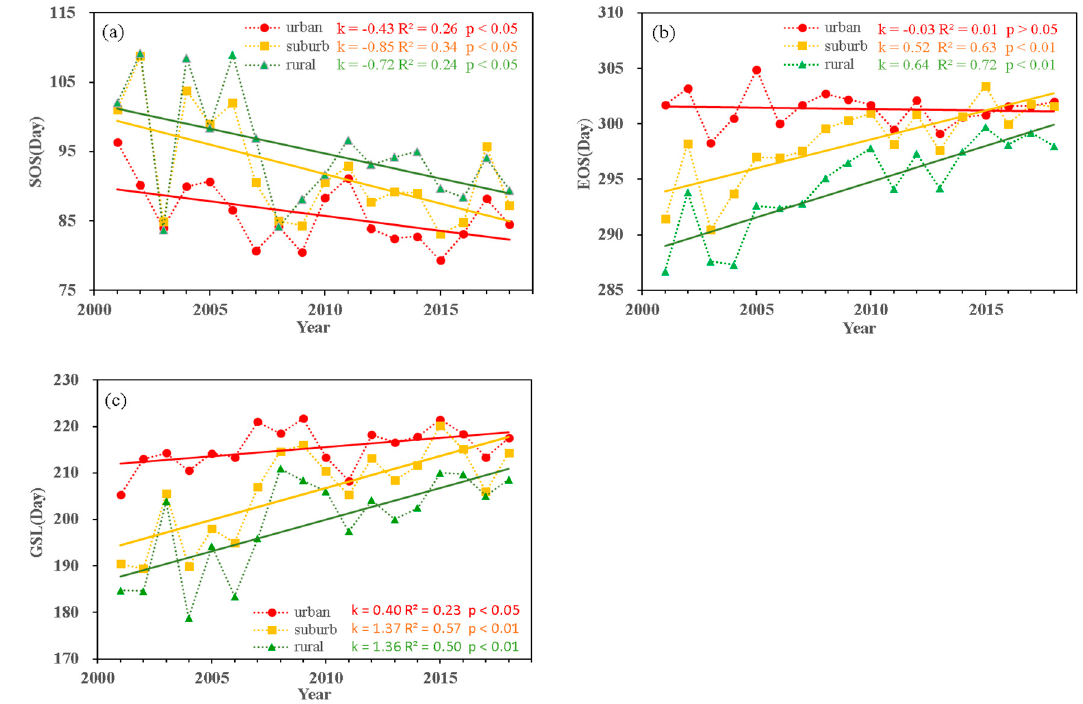
Figure 7. Inter-annual variations of ( a ) SOS, ( b ) EOS, ( c ) GSL in urban, suburban, and rural areas from 2001 to 2018. k values represent the slope of linear trends. In this analysis, the area defined as is the combined area of all bu ff er areas between 0 and 20 km from the urban suburban is the combined area of all buffer areas between 0 and 20 km from the urban edge.